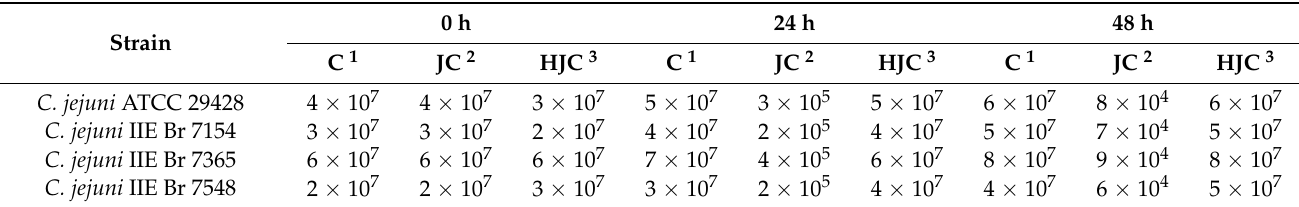
Table 5. Antagonistic activity of LF3872 against C. jejuni